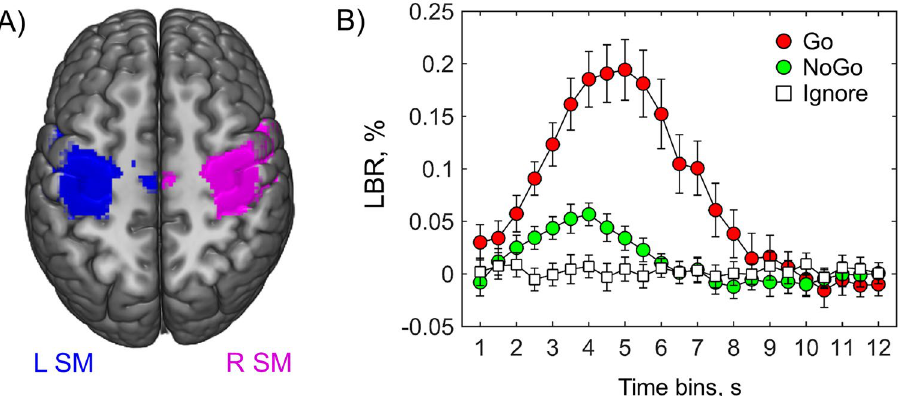
Figure 5. LBRs for the right hand (“L SM minus R SM” BOLD difference). ( A ) Sensorimotor ROIs in the left and right hemispheres (blue and violet color correspondingly). ( B ) Mean LBR (and 95% confidence intervals) for the Go, NoGo, and Ignore trials. Figure was created using MRIcroGL 1.2.2 software (https:// www. nitrc. org/ proje cts/ mricr